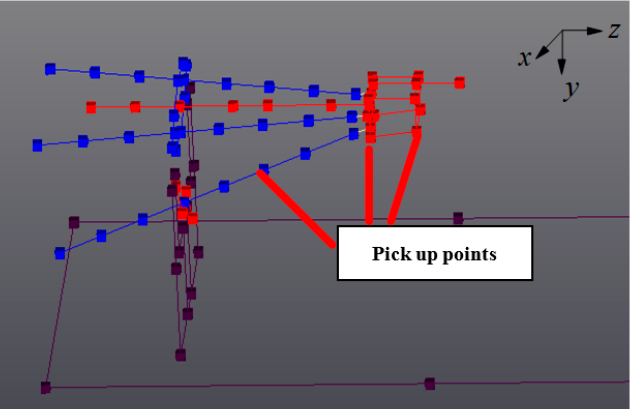
Figure 10. Arrangement of vibration pickup points on TriMule modal test. Table 7. First 4 modal parameters of the initial position of the PKM.